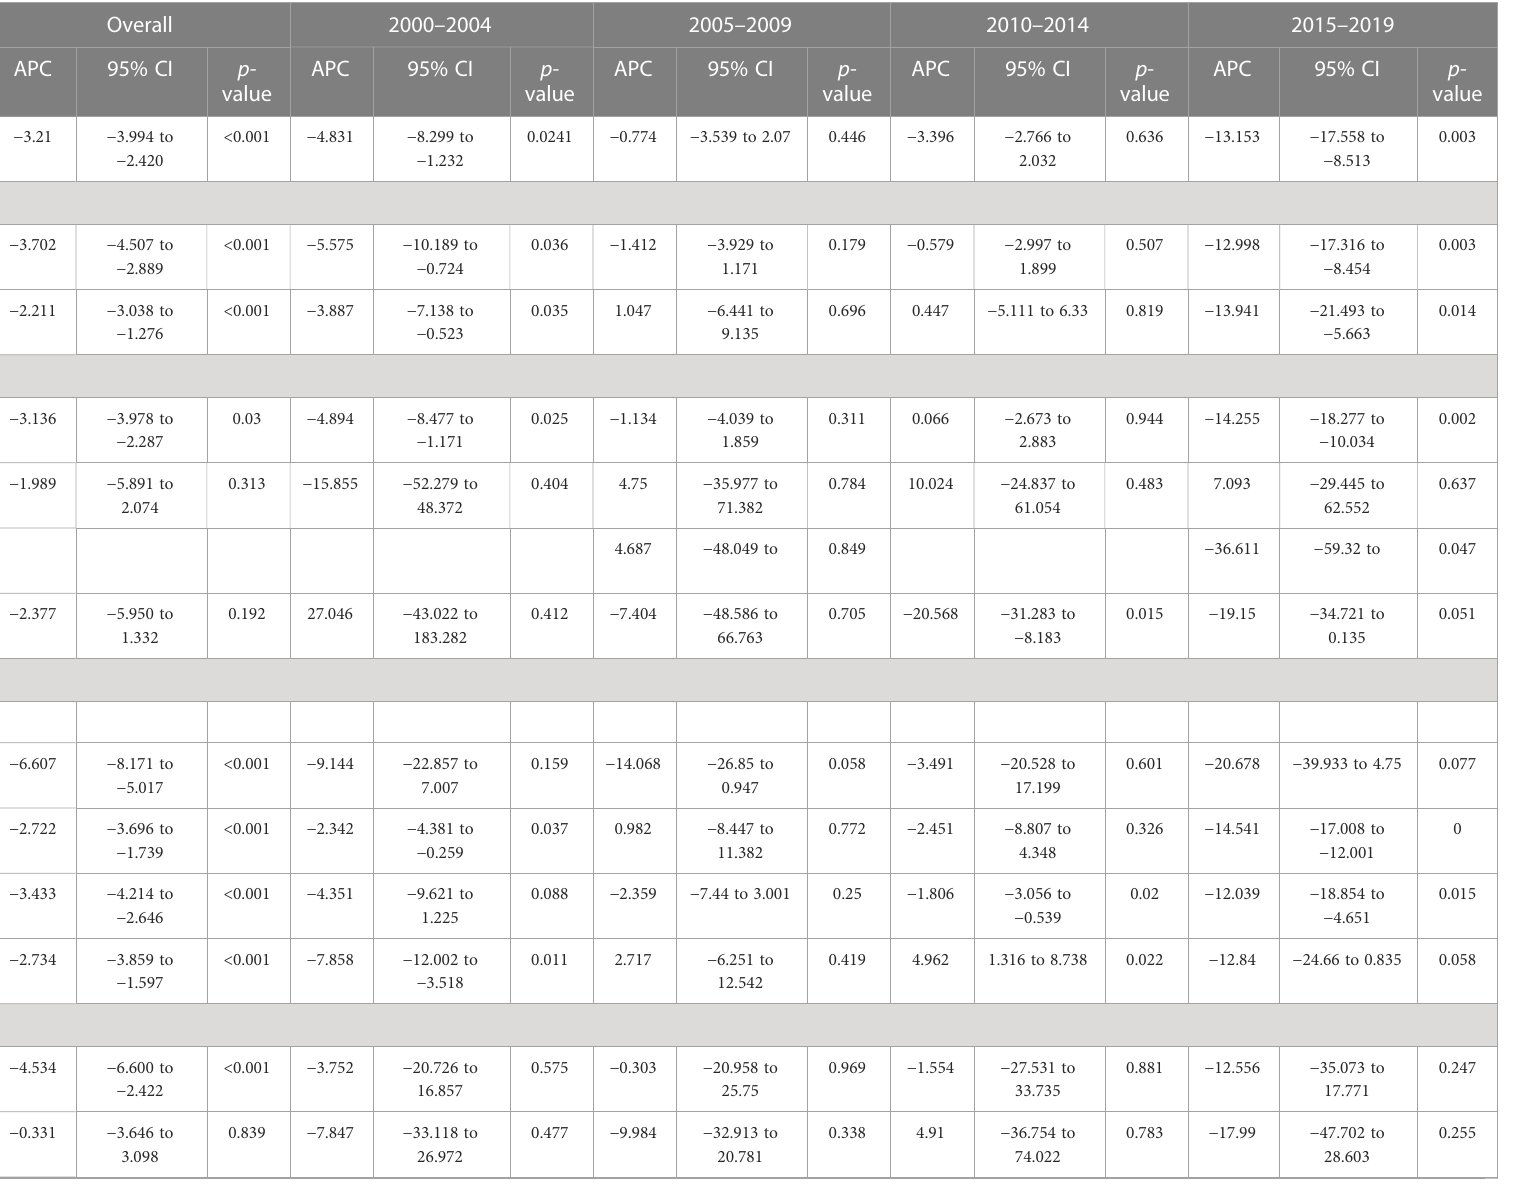
TABLE 2 Trends in cSCC on the lip incidence rates (2000 – 2019): The SEER-17 registry database.